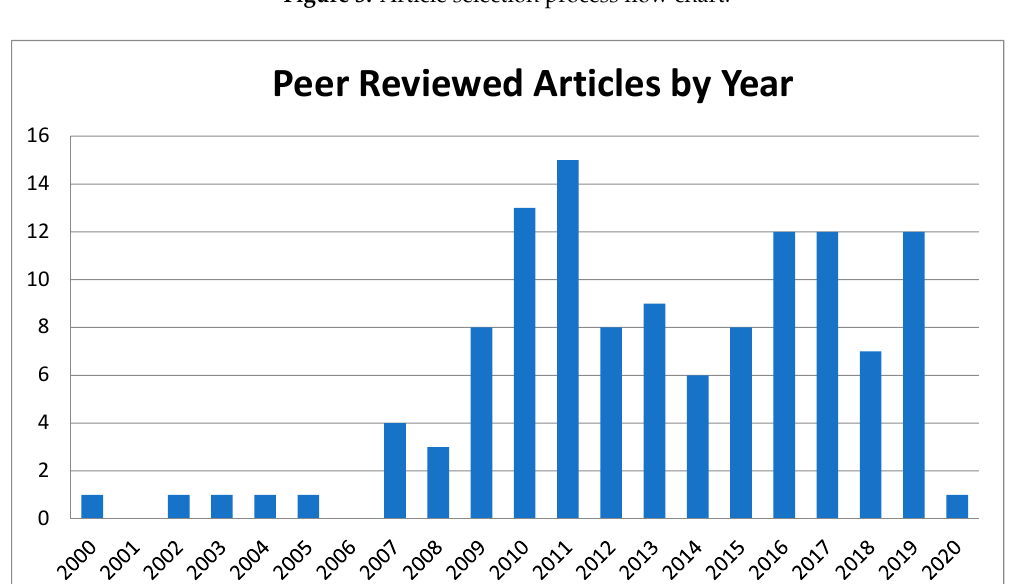
Figure 4. Research papers by date.